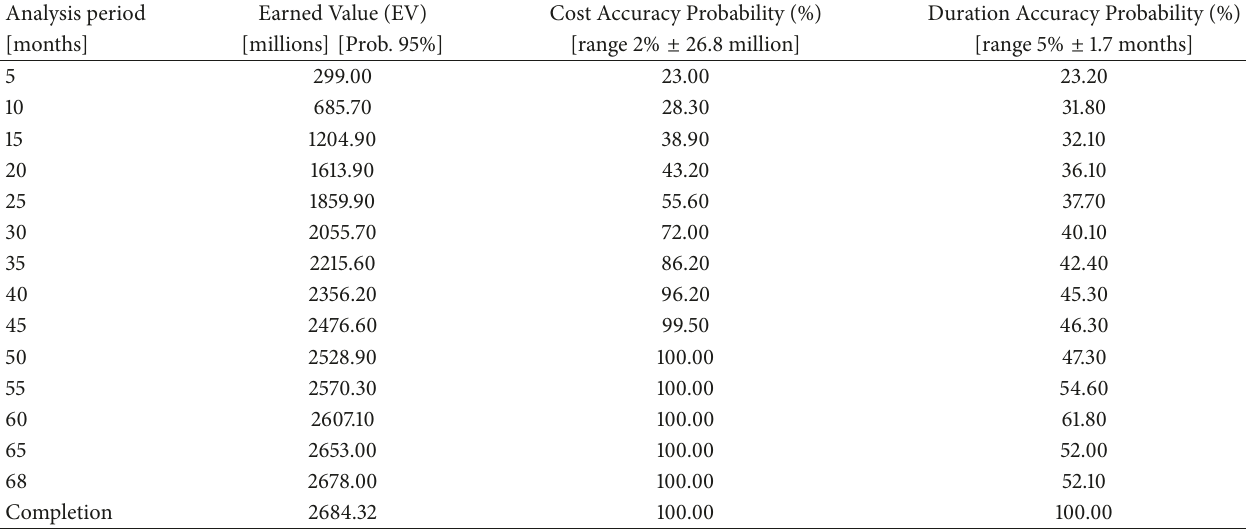
Table 5: Accuracy probability rates in cost forecasts (EVM) and duration forecasts (ES) for the Santiago project. Analysis